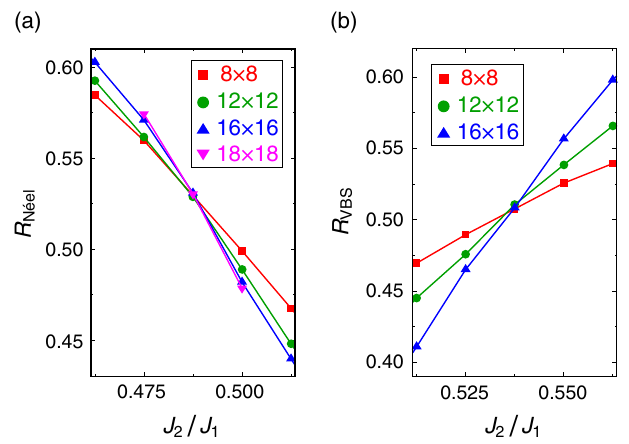
FIG. 2. System-size dependence of correlation ratio for (a) spin-spin and (b) dimer-dimer correlations, which are used to detect the phase boundary of N ´ eel-AFM and VBS, respec- tively. In (a), the 18 × 18 data are added to reinforce the